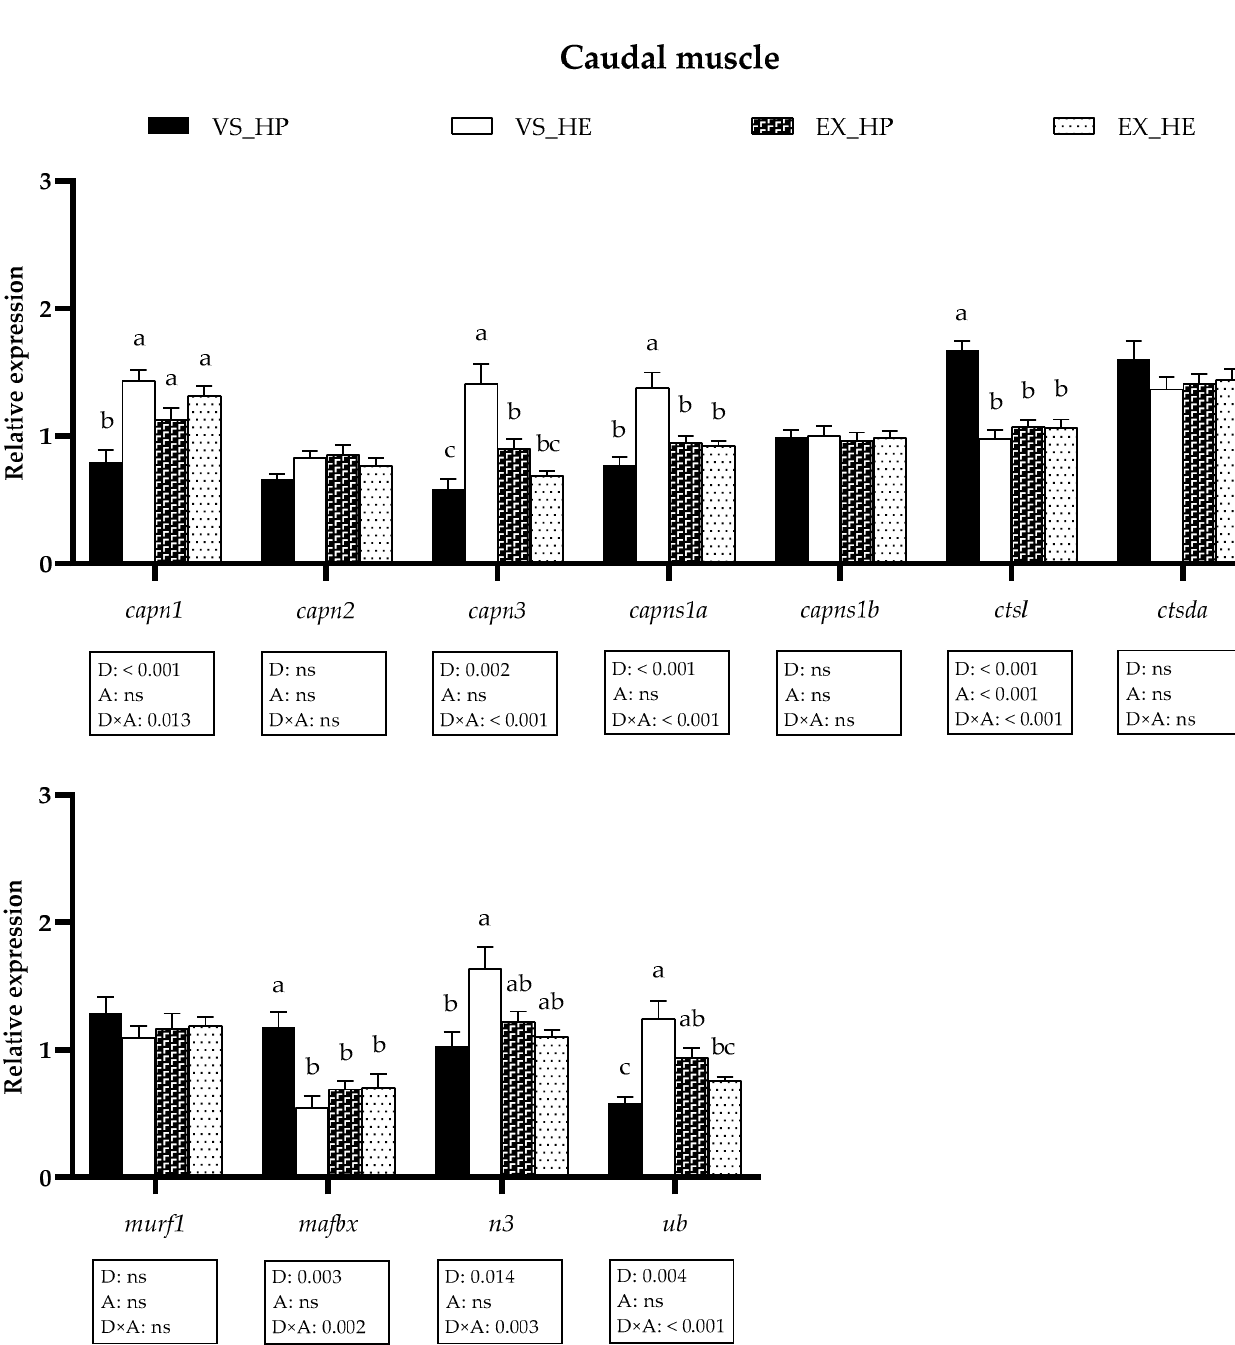
Figure 7. Relative gene expression of proteolytic markers in caudal muscle of fish under voluntary swimming (VS) or sustained exercise (EX) and fed with high-protein diet (HP) or high-energy diet (HE). Data are shown as means + SEM. VS, n = 12; EX, n = 16. Factorial statistical analysis was assessed by two-way ANOVA, and p -values of the factors diet (D), physical activity (A), and interaction (D × A) are displayed under the graph. Different letters indicate significant differences (Tukey’s post-hoc test, p < 0.05).